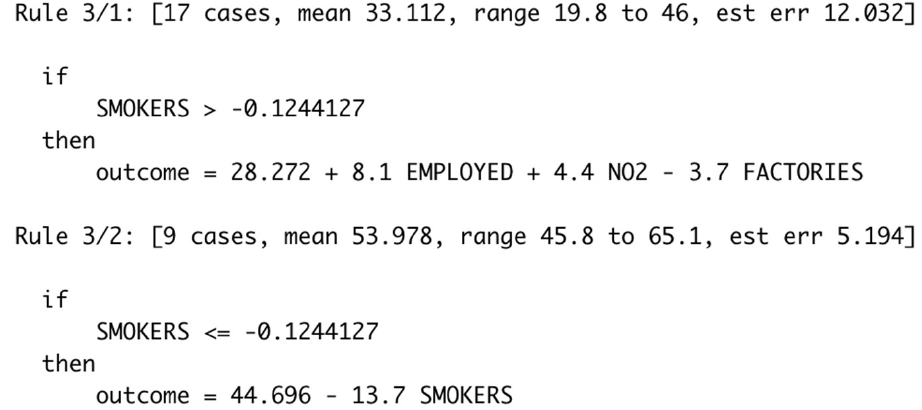
Figure 4. Cubist model tree with feature selection